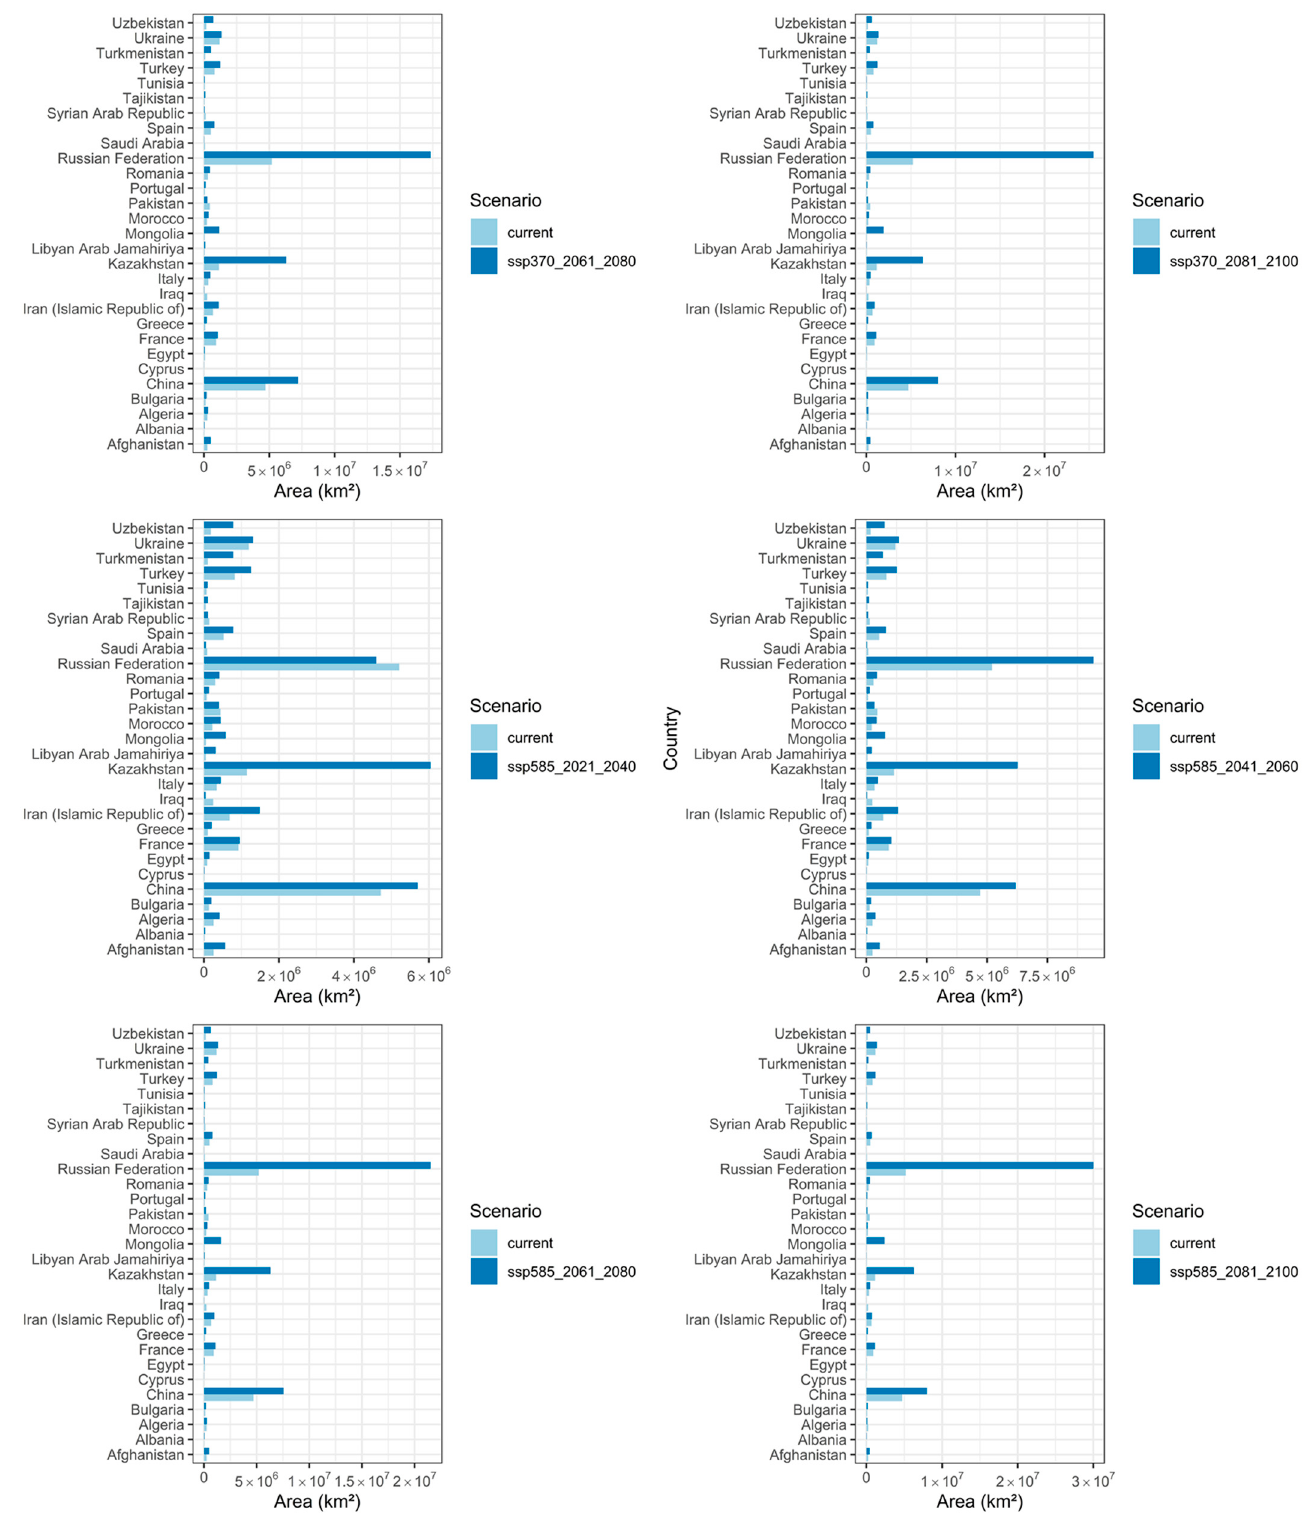
Figure A3. Changes in agricultural area by country under different climate scenarios.